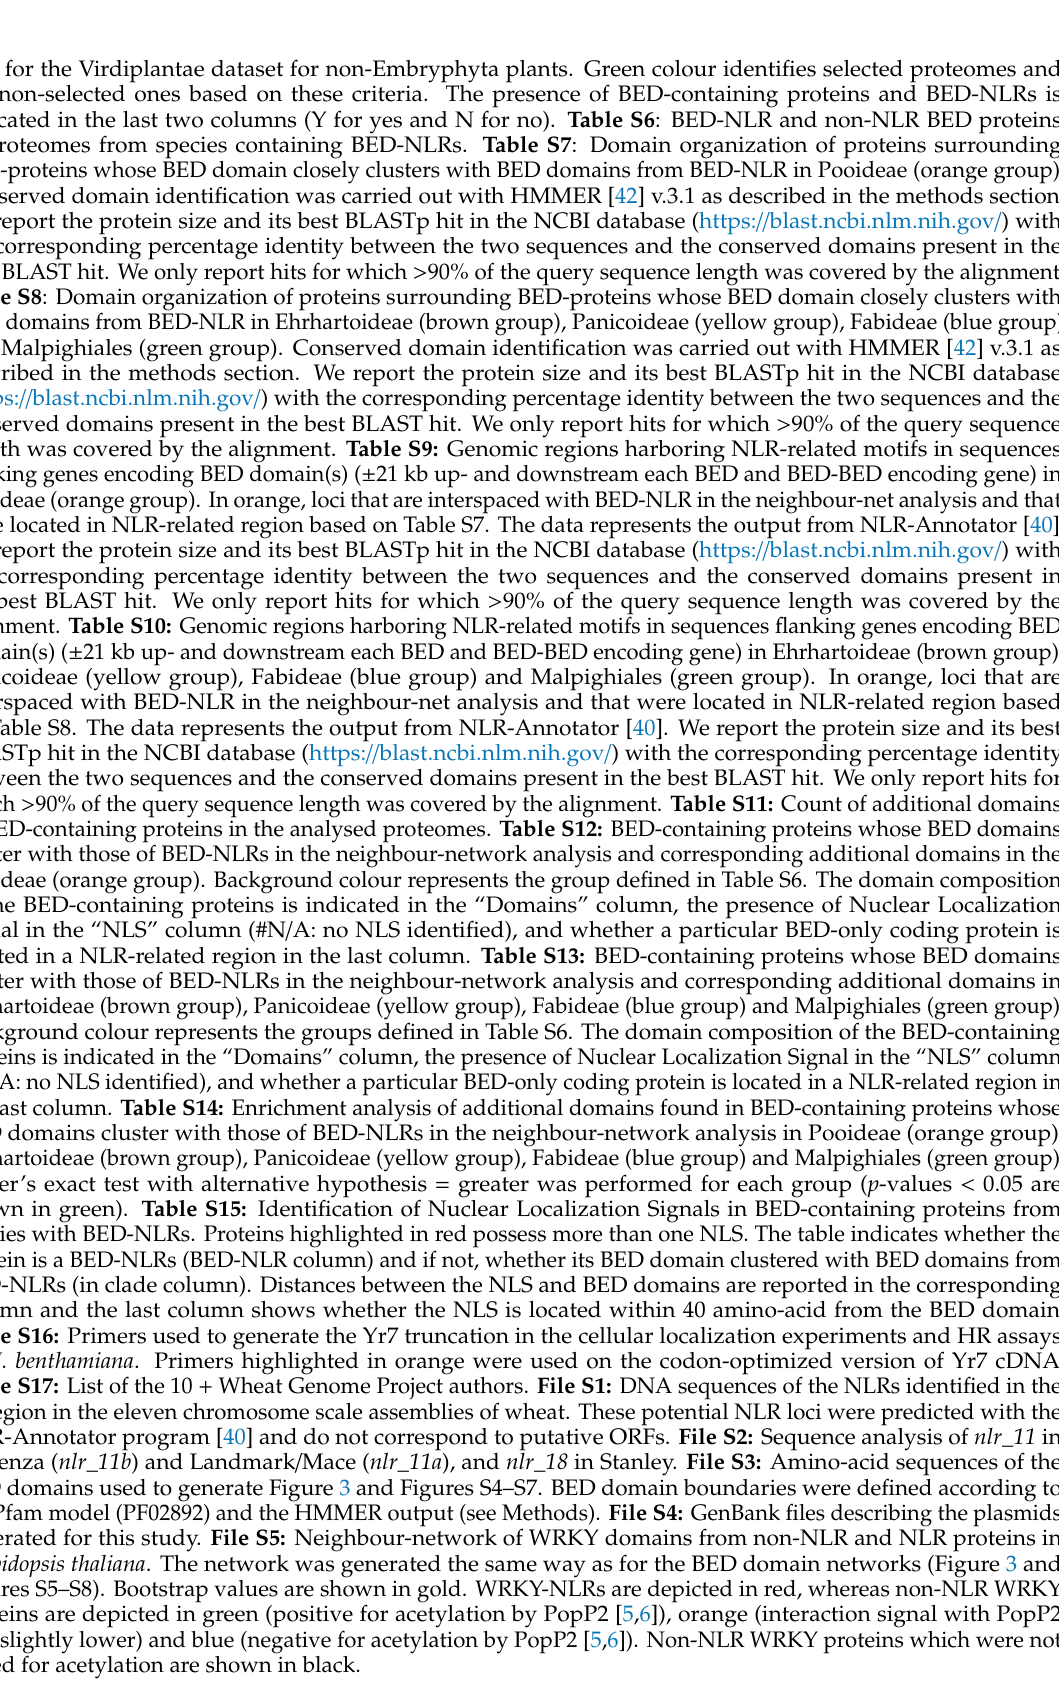
85% for the Virdiplantae dataset for non-Embryphyta plants. Green colour identifies selected proteomes and red non-selected ones based on these criteria. The presence of BED-containing proteins and BED-NLRs is indicated in the last two columns (Y for yes and N for no). Table S6 : BED-NLR and non-NLR BED proteins in proteomes from species containing BED-NLRs. Table S7 : Domain organization of proteins surrounding BED-proteins whose BED domain closely clusters with BED domains from BED-NLR in Pooideae (orange group). Conserved domain identification was carried out with HMMER [42] v.3.1 as described in the methods section. We report the protein size and its best BLASTp hit in the NCBI database (https: // blast.ncbi.nlm.nih.gov / ) with the corresponding percentage identity between the two sequences and the conserved domains present in the best BLAST hit. We only report hits for which > 90% of the query sequence length was covered by the alignment. Table S8 : Domain organization of proteins surrounding BED-proteins whose BED domain closely clusters with BED domains from BED-NLR in Ehrhartoideae (brown group), Panicoideae (yellow group), Fabideae (blue group) and Malpighiales (green group). Conserved domain identification was carried out with HMMER [42] v.3.1 as described in the methods section. We report the protein size and its best BLASTp hit in the NCBI database (https: // blast.ncbi.nlm.nih.gov / ) with the corresponding percentage identity between the two sequences and the conserved domains present in the best BLAST hit. We only report hits for which > 90% of the query sequence length was covered by the alignment. Table S9: Genomic regions harboring NLR-related motifs in sequences flanking genes encoding BED domain(s) ( ± 21 kb up- and downstream each BED and BED-BED encoding gene) in Pooideae (orange group). In orange, loci that are interspaced with BED-NLR in the neighbour-net analysis and that were located in NLR-related region based on Table S7. The data represents the output from NLR-Annotator [40]. We report the protein size and its best BLASTp hit in the NCBI database (https: // blast.ncbi.nlm.nih.gov / ) with the corresponding percentage identity between the two sequences and the conserved domains present in the best BLAST hit. We only report hits for which > 90% of the query sequence length was covered by the alignment. Table S10: Genomic regions harboring NLR-related motifs in sequences flanking genes encoding BED domain(s) ( ± 21 kb up- and downstream each BED and BED-BED encoding gene) in Ehrhartoideae (brown group), Panicoideae (yellow group), Fabideae (blue group) and Malpighiales (green group). In orange, loci that are interspaced with BED-NLR in the neighbour-net analysis and that were located in NLR-related region based on Table S8. The data represents the output from NLR-Annotator [40]. We report the protein size and its best BLASTp hit in the NCBI database (https: // blast.ncbi.nlm.nih.gov / ) with the corresponding percentage identity between the two sequences and the conserved domains present in the best BLAST hit. We only report hits for which > 90% of the query sequence length was covered by the alignment. Table S11: Count of additional domains in BED-containing proteins in the analysed proteomes. Table S12: BED-containing proteins whose BED domains cluster with those of BED-NLRs in the neighbour-network analysis and corresponding additional domains in the Pooideae (orange group). Background colour represents the group defined in Table S6. The domain composition of the BED-containing proteins is indicated in the “Domains” column, the presence of Nuclear Localization Signal in the “NLS” column (#N / A: no NLS identified), and whether a particular BED-only coding protein is located in a NLR-related region in the last column. Table S13: BED-containing proteins whose BED domains cluster with those of BED-NLRs in the neighbour-network analysis and corresponding additional domains in Ehrhartoideae (brown group), Panicoideae (yellow group), Fabideae (blue group) and Malpighiales (green group). Background colour represents the groups defined in Table S6. The domain composition of the BED-containing proteins is indicated in the “Domains” column, the presence of Nuclear Localization Signal in the “NLS” column (#N / A: no NLS identified), and whether a particular BED-only coding protein is located in a NLR-related region in the last column. Table S14: Enrichment analysis of additional domains found in BED-containing proteins whose BED domains cluster with those of BED-NLRs in the neighbour-network analysis in Pooideae (orange group), Ehrhartoideae (brown group), Panicoideae (yellow group), Fabideae (blue group) and Malpighiales (green group) . Fisher’s exact test with alternative hypothesis = greater was performed for each group ( p -values < 0.05 are shown in green). Table S15: Identification of Nuclear Localization Signals in BED-containing proteins from species with BED-NLRs. Proteins highlighted in red possess more than one NLS. The table indicates whether the protein is a BED-NLRs (BED-NLR column) and if not, whether its BED domain clustered with BED domains from BED-NLRs (in clade column). Distances between the NLS and BED domains are reported in the corresponding column and the last column shows whether the NLS is located within 40 amino-acid from the BED domain. Table S16: Primers used to generate the Yr7 truncation in the cellular localization experiments and HR assays in N. benthamiana . Primers highlighted in orange were used on the codon-optimized version of Yr7 cDNA. Table S17: List of the 10 + Wheat Genome Project authors. File S1: DNA sequences of the NLRs identified in the Yr region in the eleven chromosome scale assemblies of wheat. These potential NLR loci were predicted with the NLR-Annotator program [40] and do not correspond to putative ORFs. File S2: Sequence analysis of nlr_11 in Cadenza ( nlr_11b ) and Landmark / Mace ( nlr_11a ), and nlr_18 in Stanley. File S3: Amino-acid sequences of the BED domains used to generate Figure 3 and Figures S4–S7. BED domain boundaries were defined according to the Pfam model (PF02892) and the HMMER output (see Methods). File S4: GenBank files describing the plasmids generated for this study. File S5: Neighbour-network of WRKY domains from non-NLR and NLR proteins in Arabidopsis thaliana . The network was generated the same way as for the BED domain networks (Figure 3 and Figures S5–S8). Bootstrap values are shown in gold. WRKY-NLRs are depicted in red, whereas non-NLR WRKY proteins are depicted in green (positive for acetylation by PopP2 [5,6]), orange (interaction signal with PopP2 was slightly lower) and blue (negative for acetylation by PopP2 [5,6]). Non-NLR WRKY proteins which were not tested for acetylation are shown in